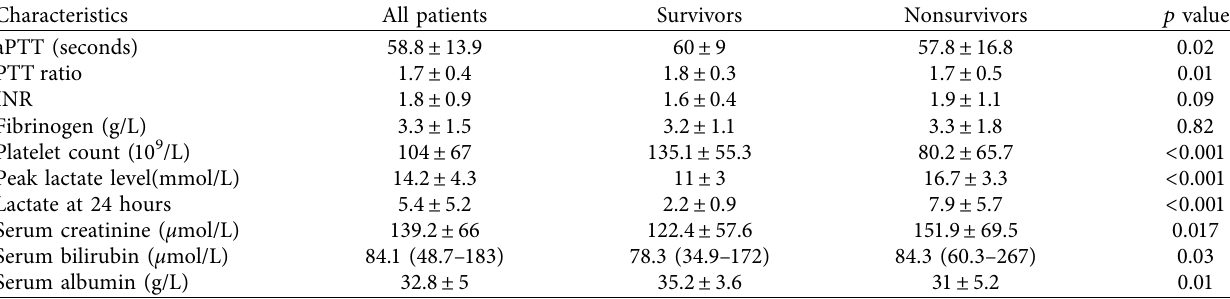
Table 4: Laboratory data during ECMO support.